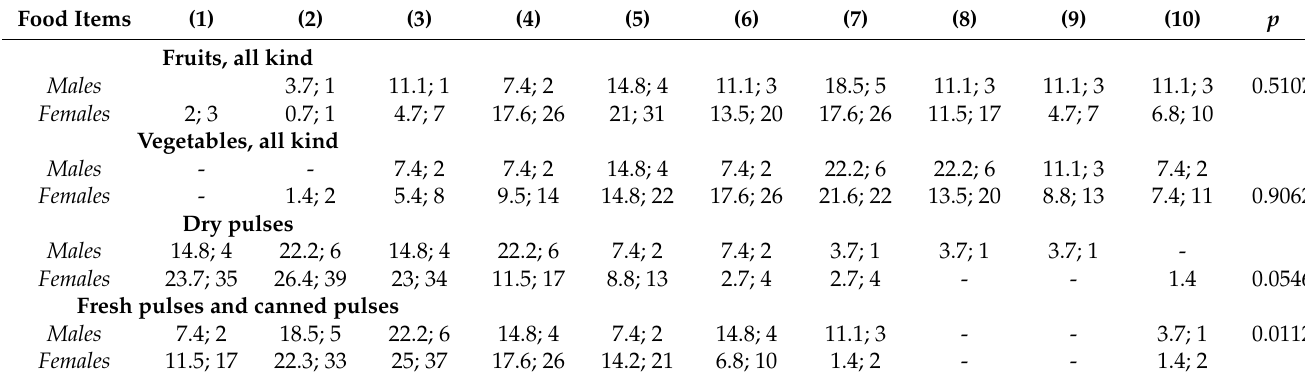
Table 17. Kind and frequency (%; n ) of different food products consumption in males and